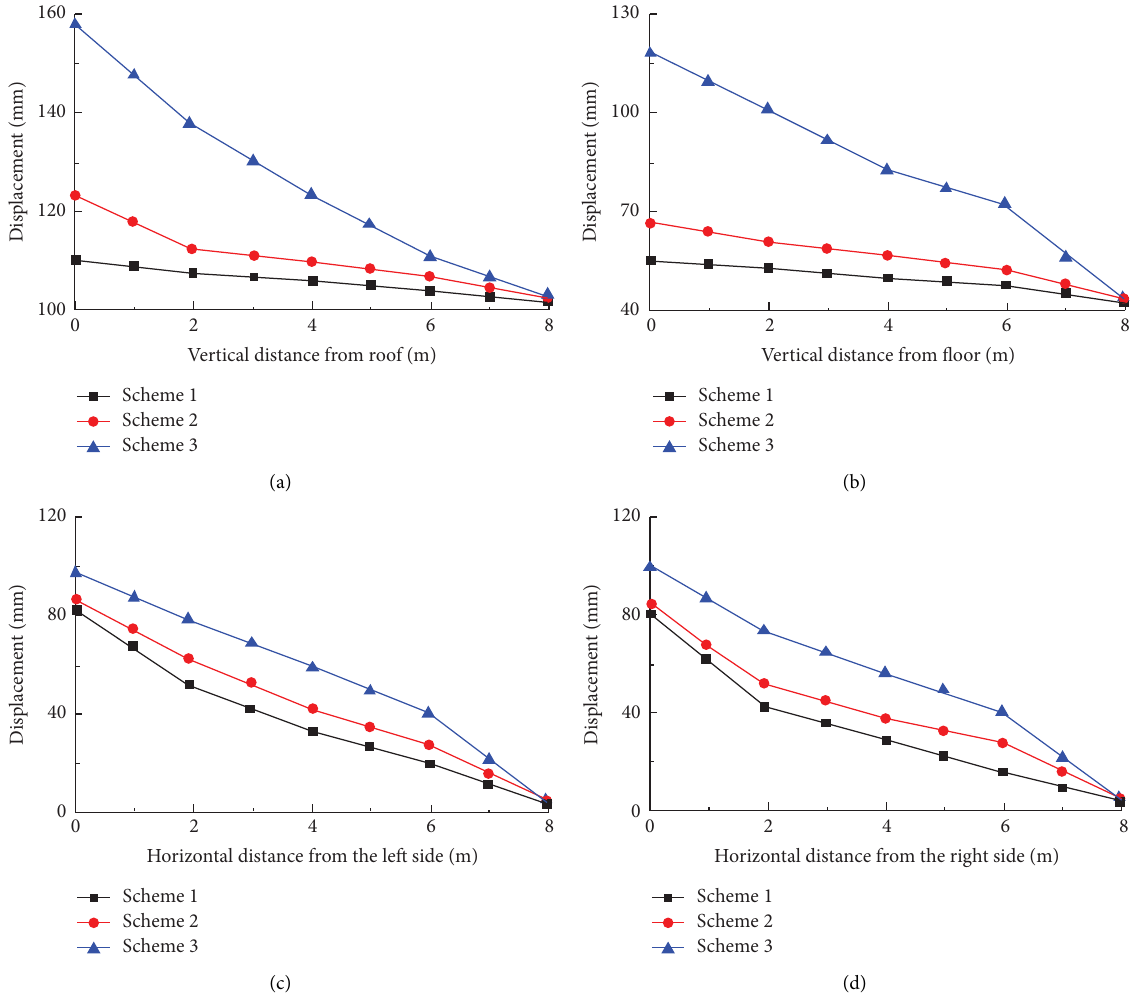
Figure 11: Deformation at diferent positions of roadway. (a) Diferent positions of roof, (b) diferent positions of foor, (c) diferent positions of left side, and (d) diferent positions of right side.